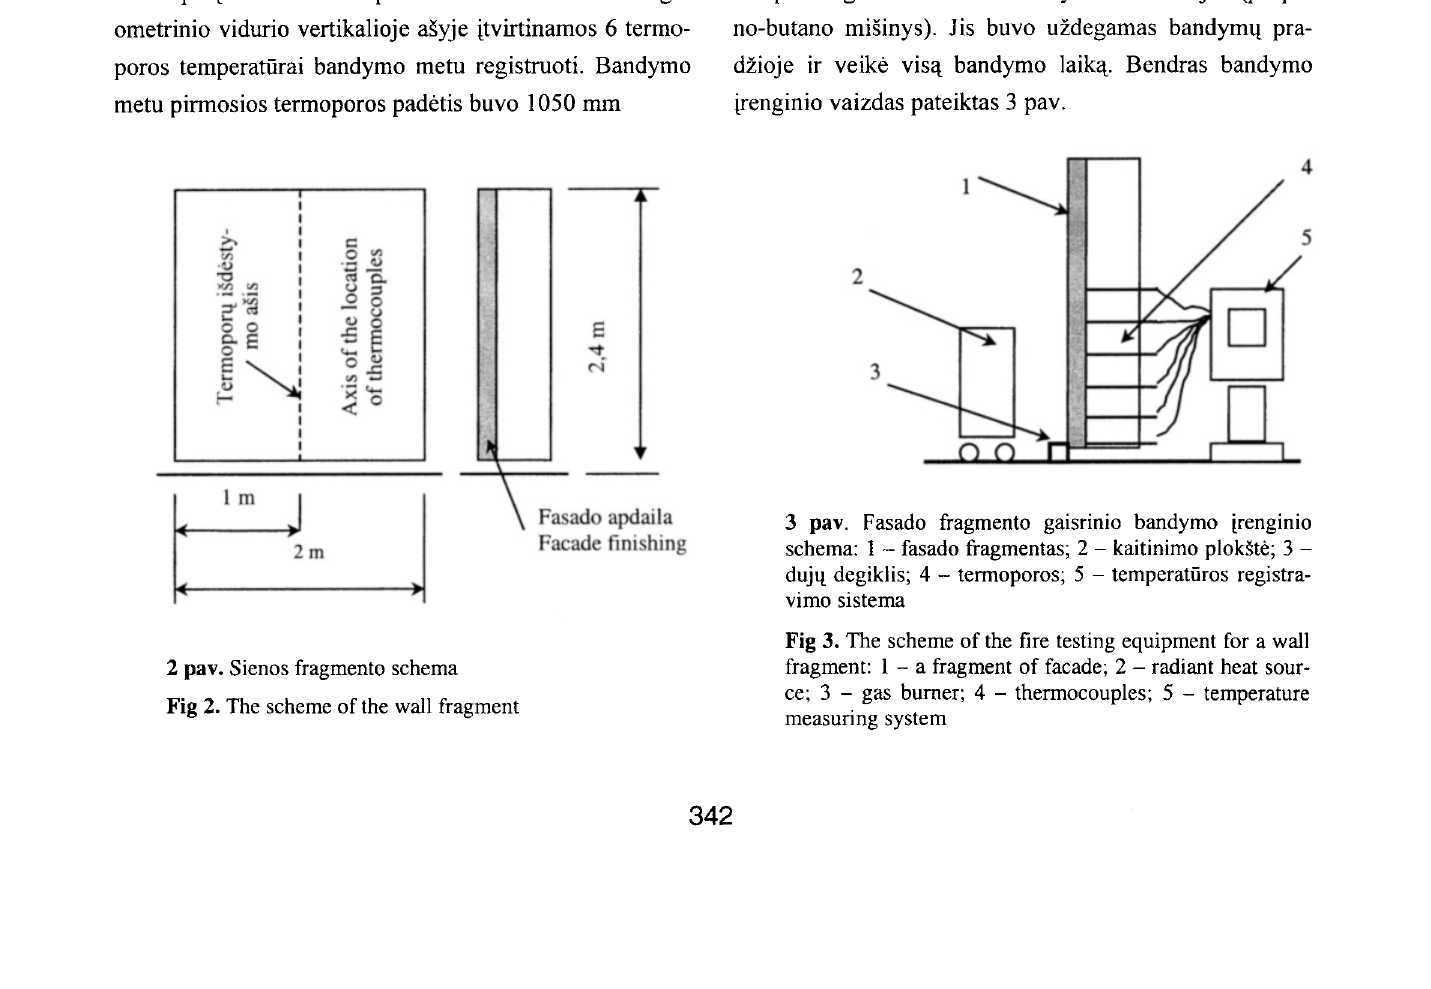
Fig 2. The scheme of the wall fragment